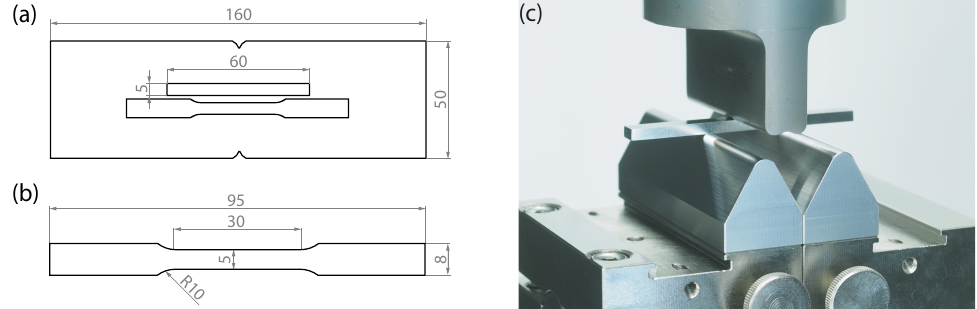
Figure 2. ( a ) Extraction of the specimens with thickness 2.8mm for the mechanical tests from the welded sheets with the dimensions of the bending sample, ( b ) Dimension of the tensile specimen, ( c ) Test setup for performing the bending